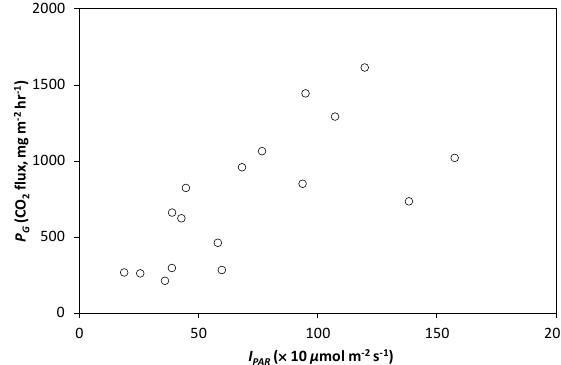
Figure 2. Variation in gross photosynthesis ( P with photosynthetically active radiation for one of the collars at the North Wales blanket peatland site. Note that for the purposes of plotting, P given as positive